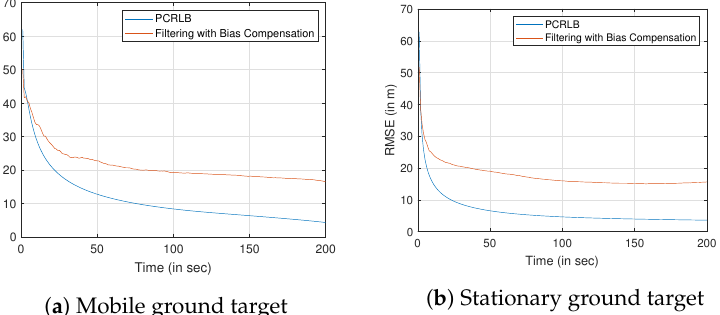
Figure 13. RMSE evaluation for tracking a ground target using airborne sensor platform with angle-only bias-compensated measurements.